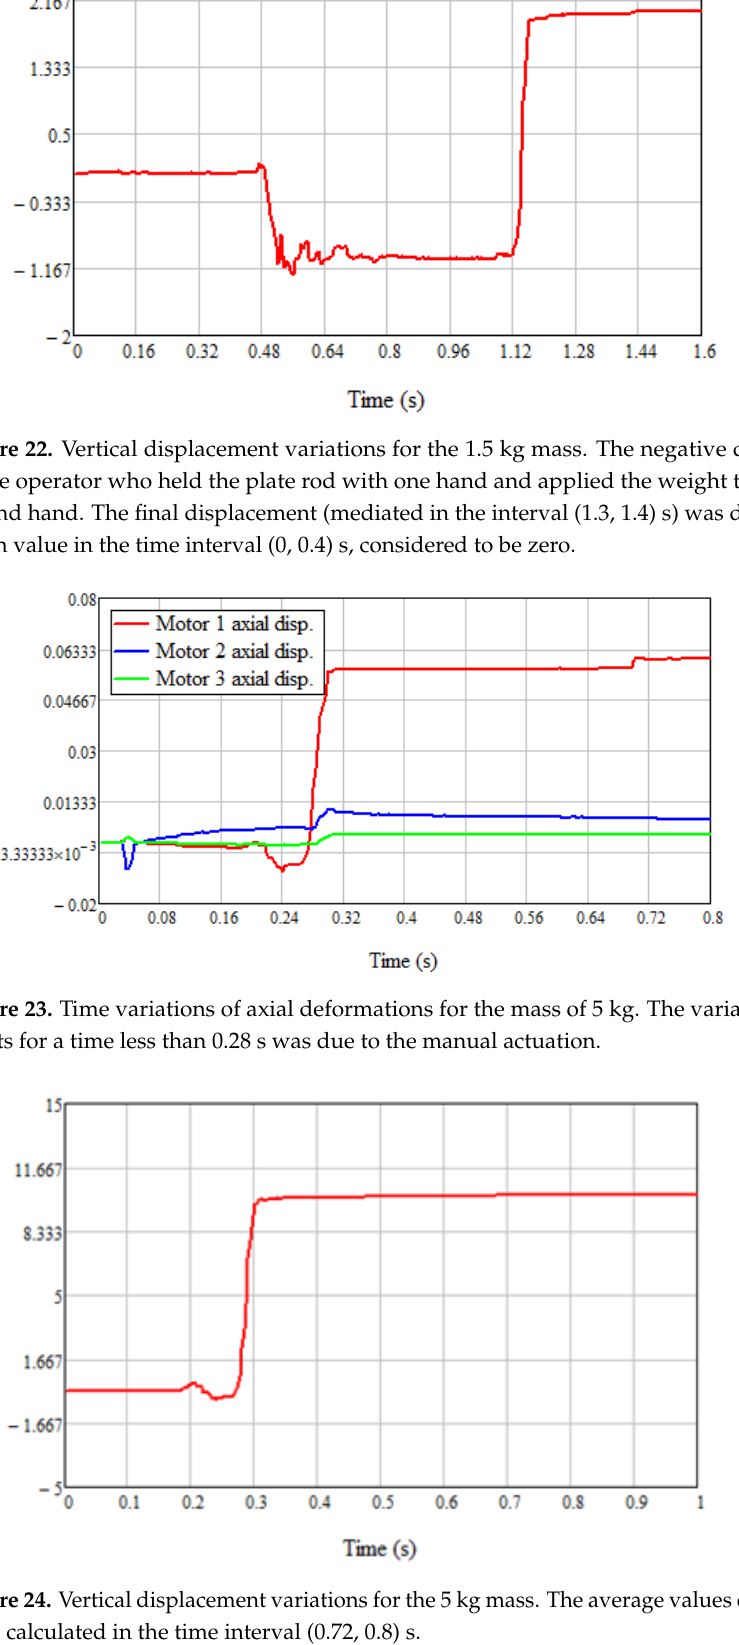
Figure 21. Time variations of axial deformations for the mass of 1.5 kg. The average values of the displacements after the application of the weight were calculated in the time interval (1.3, 1.4) s.